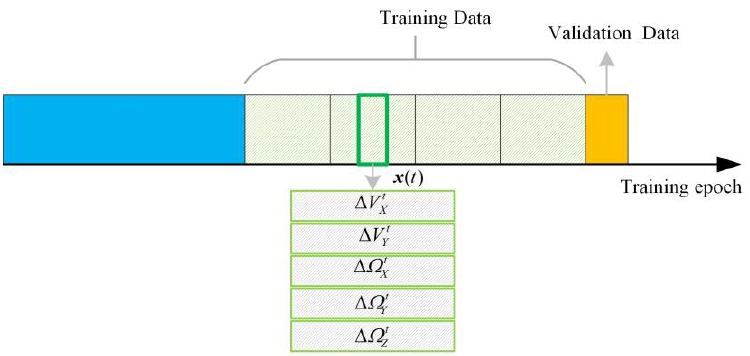
Figure 7. The data structure of the LSTM training mode.